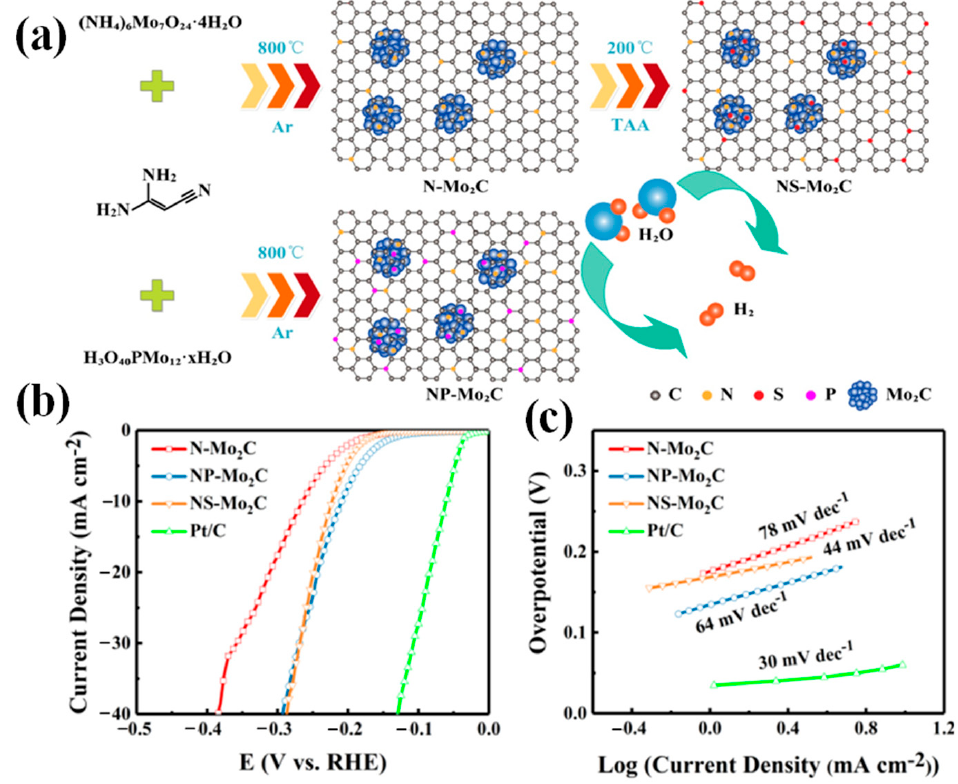
Figure 7. ( a ) Synthesis scheme of NP-Mo 2 C and NS-Mo 2 C. ( b ) Polarization curves. ( c ) Tafel plots. Reproduced with permission from [56]. Copyright 2018, Elsevier.